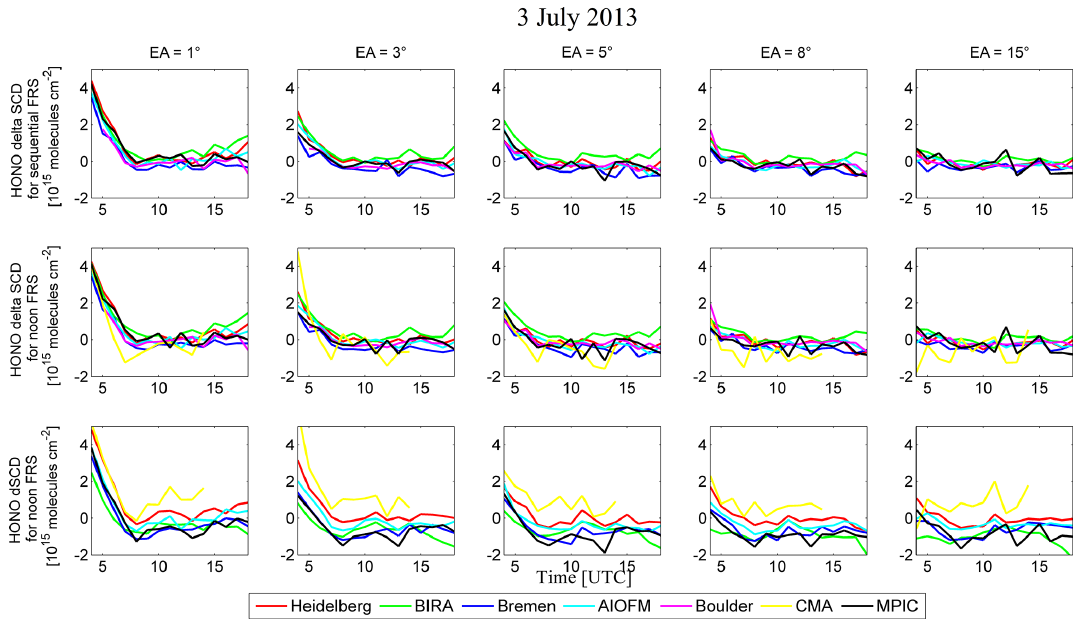
Figure 3. Time series of the hourly averaged values of HONO delta SCDs using a sequential FRS and a daily noon FRS as well as the HONO dSCDs with a daily noon FRS for different elevation angles and participating instruments on 3 July